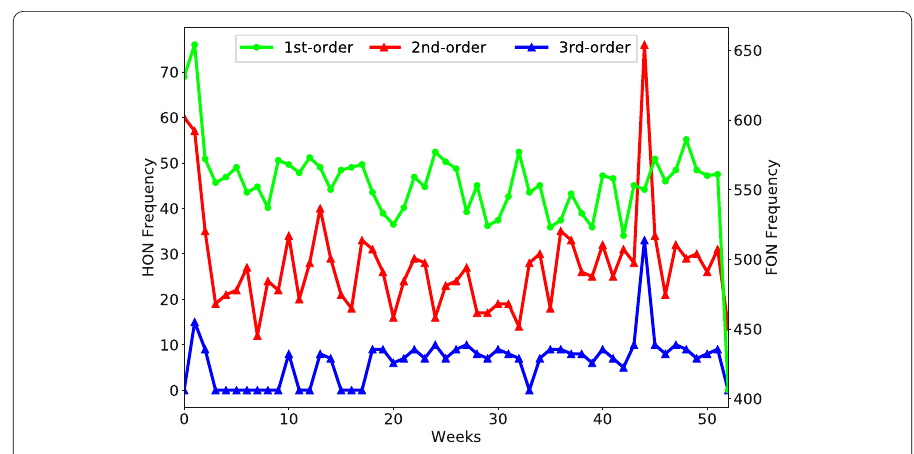
Figure 9 Variation of number of first-order, second-order and third-order nodes in HON of the taxi data of Porto. The anomalous traffic patterns result in a significant change in the number of second and third-order nodes, but not the first-order